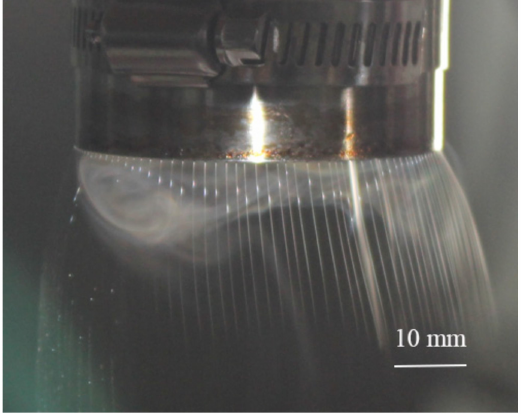
Figure 13. Melt needleless electrospinning with 52 mm annular tip